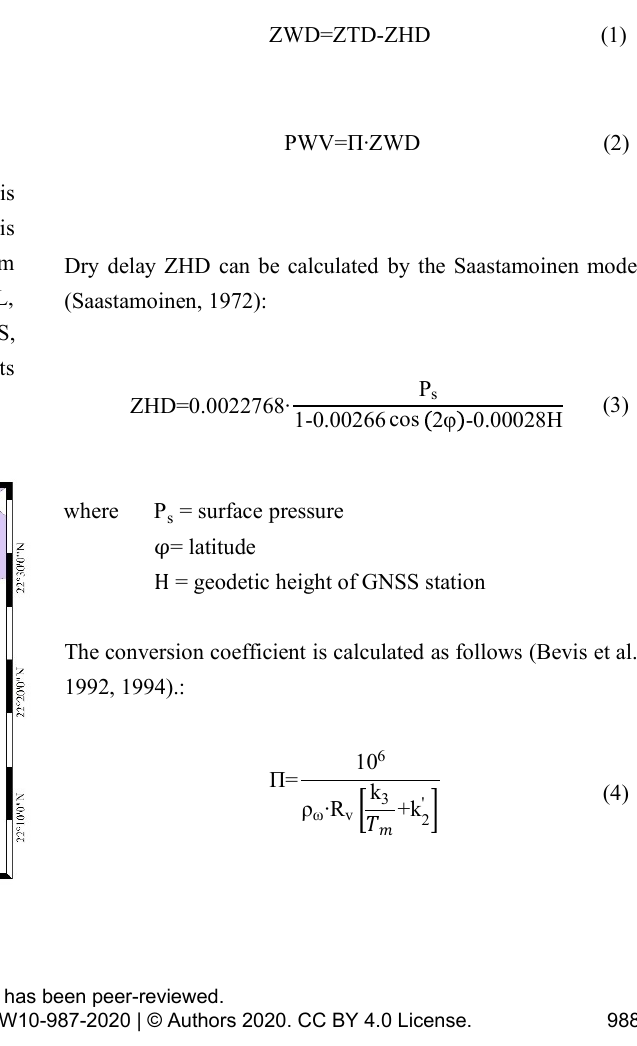
Figure 1. SatRef point distribution map of Hong Kong In addition, get the data for the same time of ERA5 hourly estimates of the variables on the pressure levels' with a horizontal resolution of 0.25 ° ×0.25 ° ， covering pressure P(hPa), geopotential Z(m 2 ∙s 2 ) , temperature T(K) , Specific humidity q(kg∙kg -1 ), relative humidity R(%),